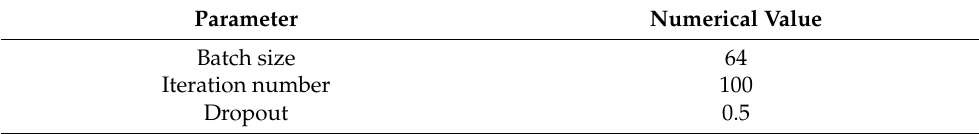
Table 4. Model training